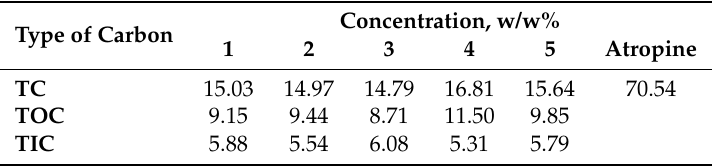
Table 5. Total carbon (TC), total organic carbon (TOC) and total inorganic carbon (TIC) contents evaluated by dry combustion